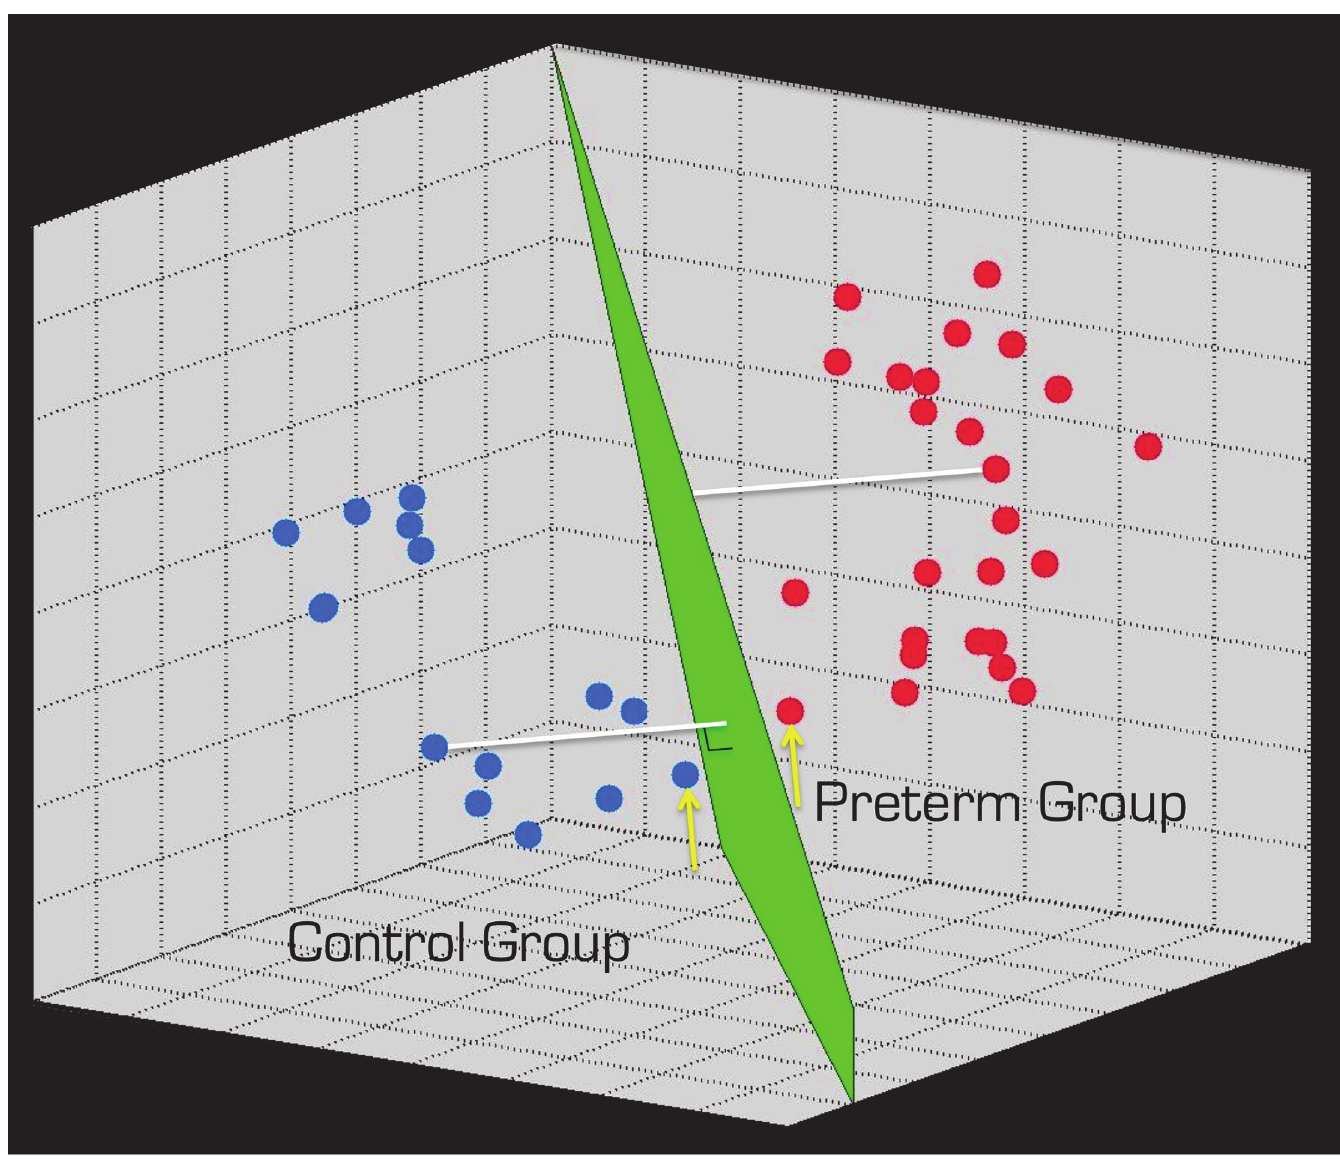
Fig 1. Illustrative representation of the SVM method. Although, SVMs work in multidimensional space where the dimensionality depends on the number voxels in the MR image, for simplicity and to aid the visual explanation, here only a 3D representation is shown. The filled blue and red circles represent hypothetical data from the two groups of interest. The green plane (which would be a called hyper plane in higher dimensions) between the clustered circles represents the decision boundary, consisting of points that maximize the distance (indicated by white lines) between the two groups. The most ambiguous points (i.e. closes to the plane) are called the ‘ support vectors ’ (indicated by yellow arrows).